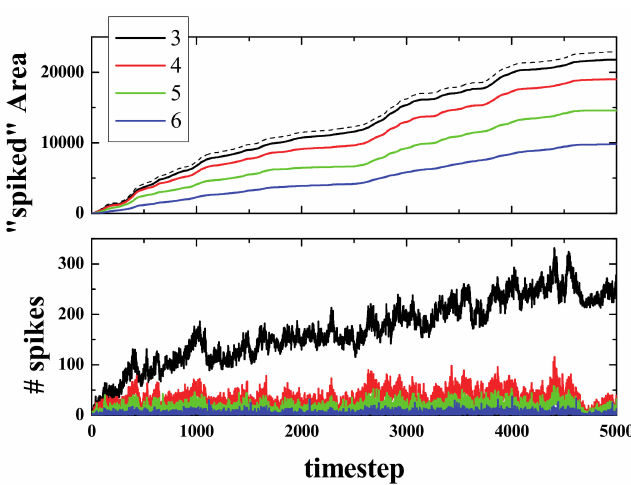
Figure 10. (Color online) The acorn simulation. Spiked area (top panel) and total number of spikes (bottom panel) vs. time (See Video 2) with different spiking rules, as labeled. The dashed black line on top represents the total active area A A .